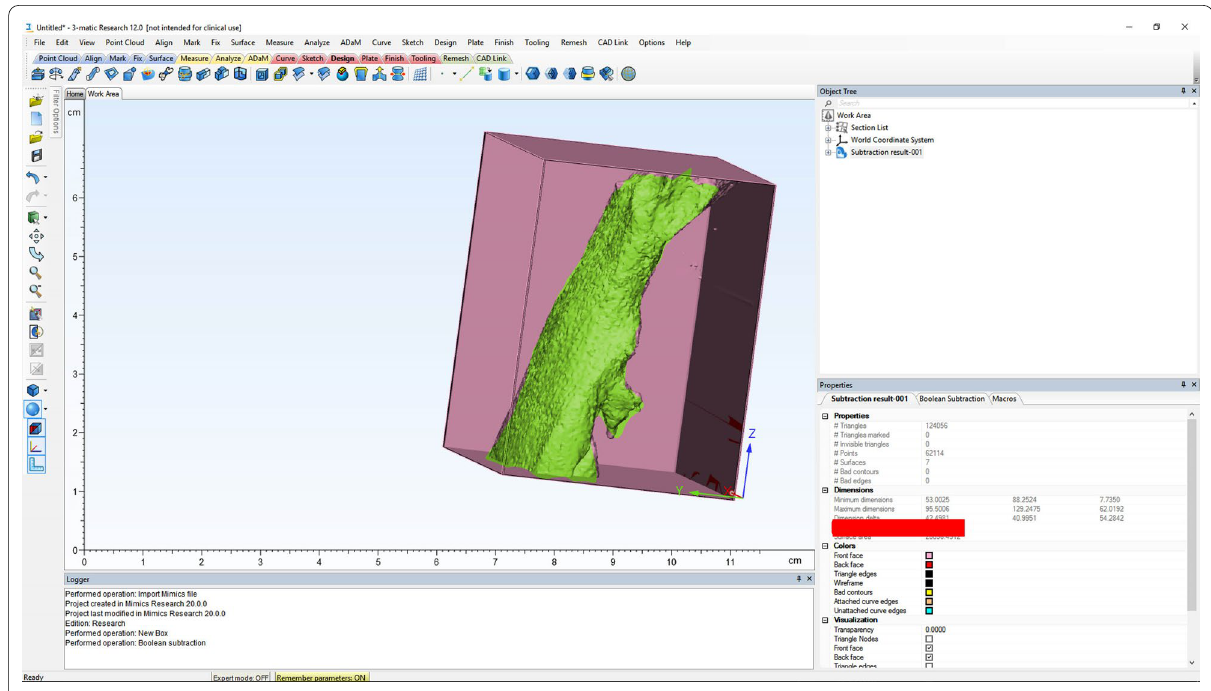
Fig. 3 Measuring the oropharyngeal airway volume